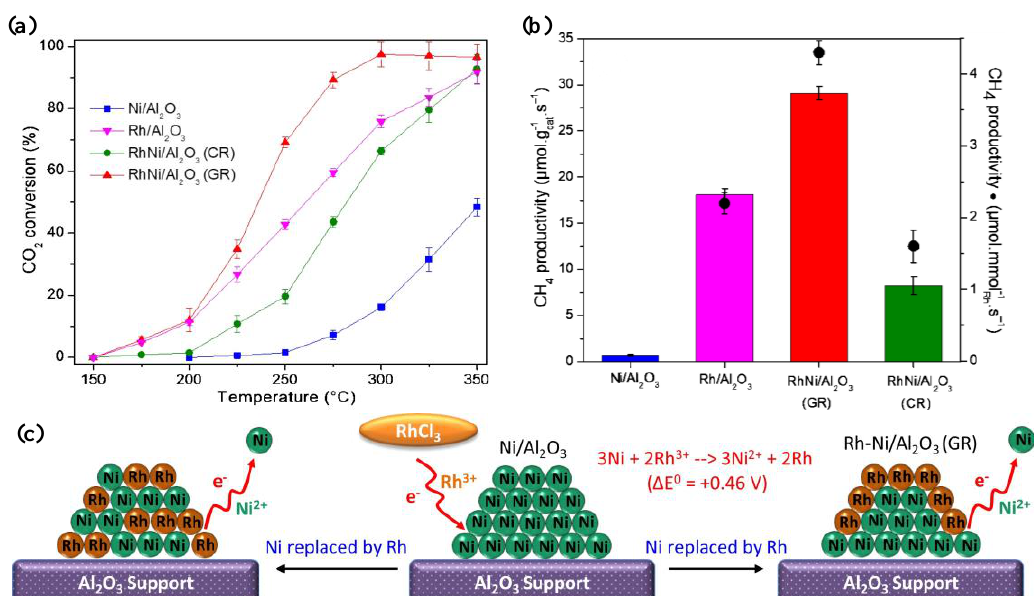
Figure 12. Catalytic activity of Ni/Al 2 O 3 , Rh/Al 2 O 3 , RhNi/Al 2 O 3 (CR), and RhNi/Al 2 O 3 (GR) for CO 2 methanation: ( a ) CO 2 conversion versus reaction temperature; ( b ) Rh normalised CH 4 productivity at 250 °C. ( c ) Possible structures of as-pre- pared bimetallic RhNi/Al 2 O 3 catalysts synthesised by galvanic replacement. Reproduced with permission from [117]. Cop-